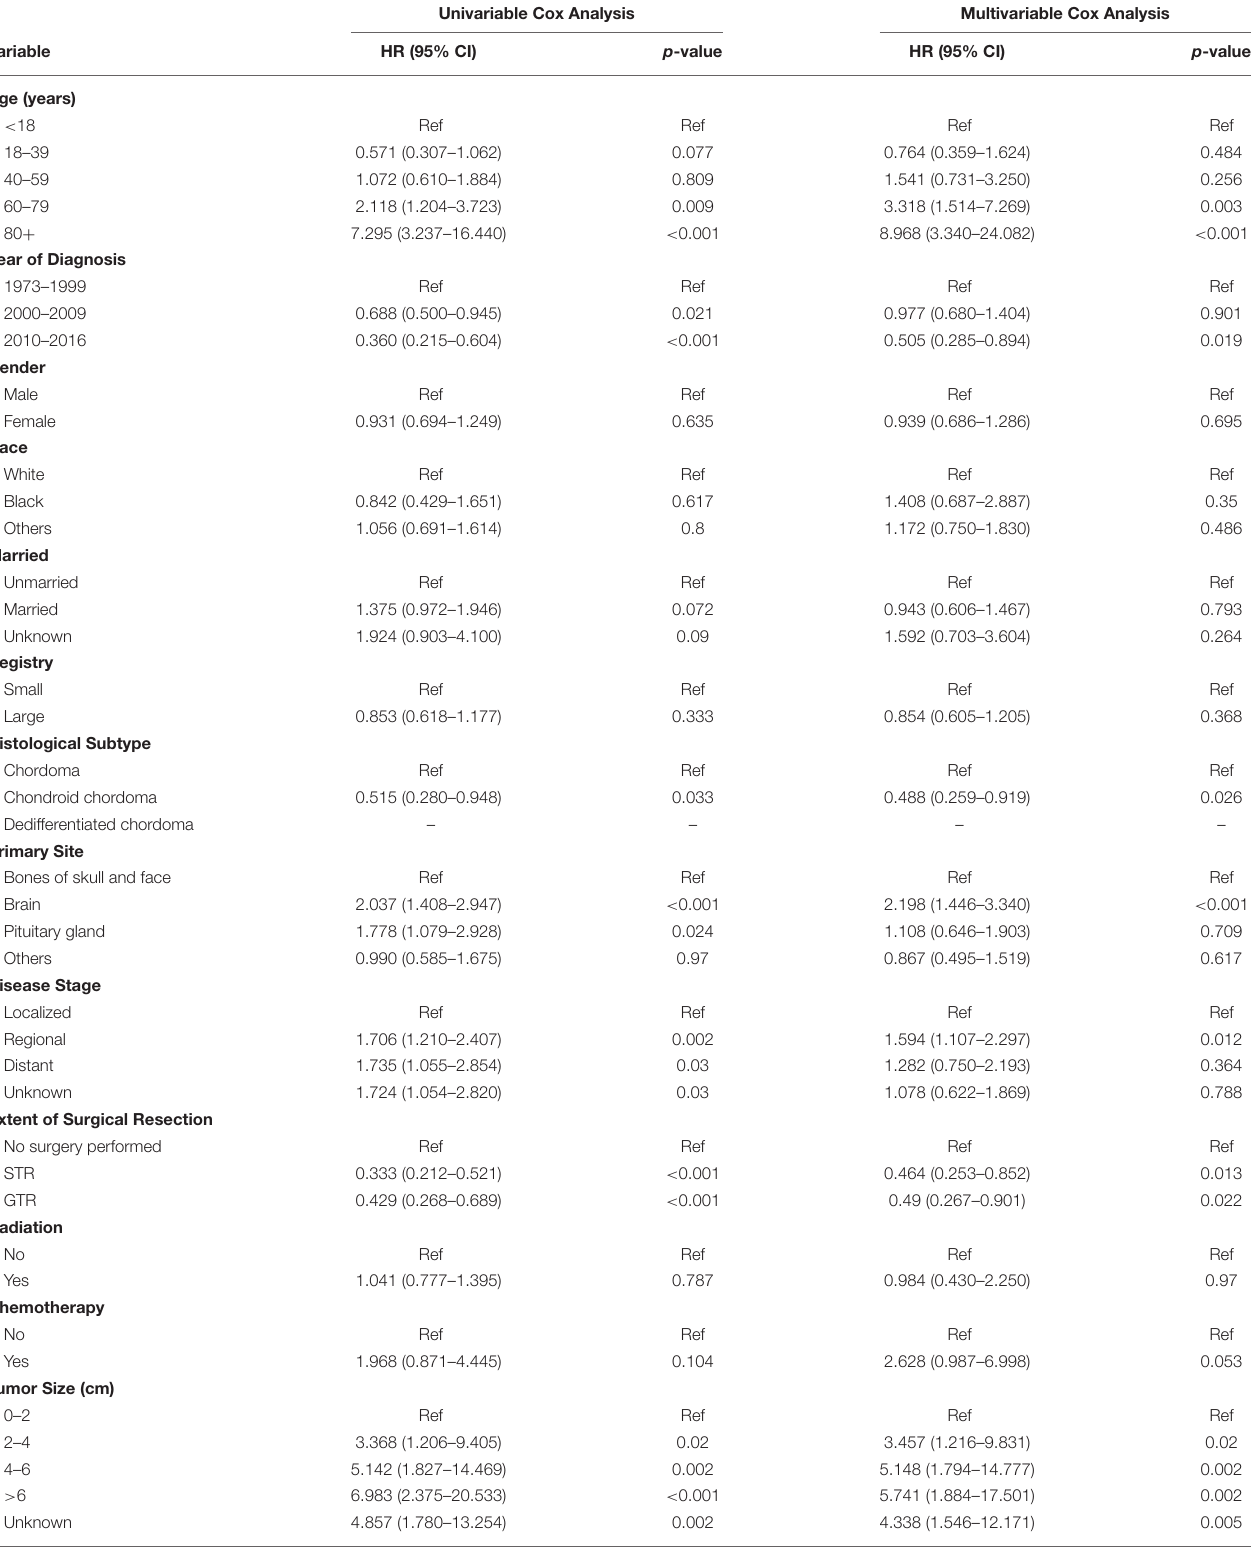
TABLE 2 | Univariate and multivariate analysis of the prognostic factors of patients with primary skull base